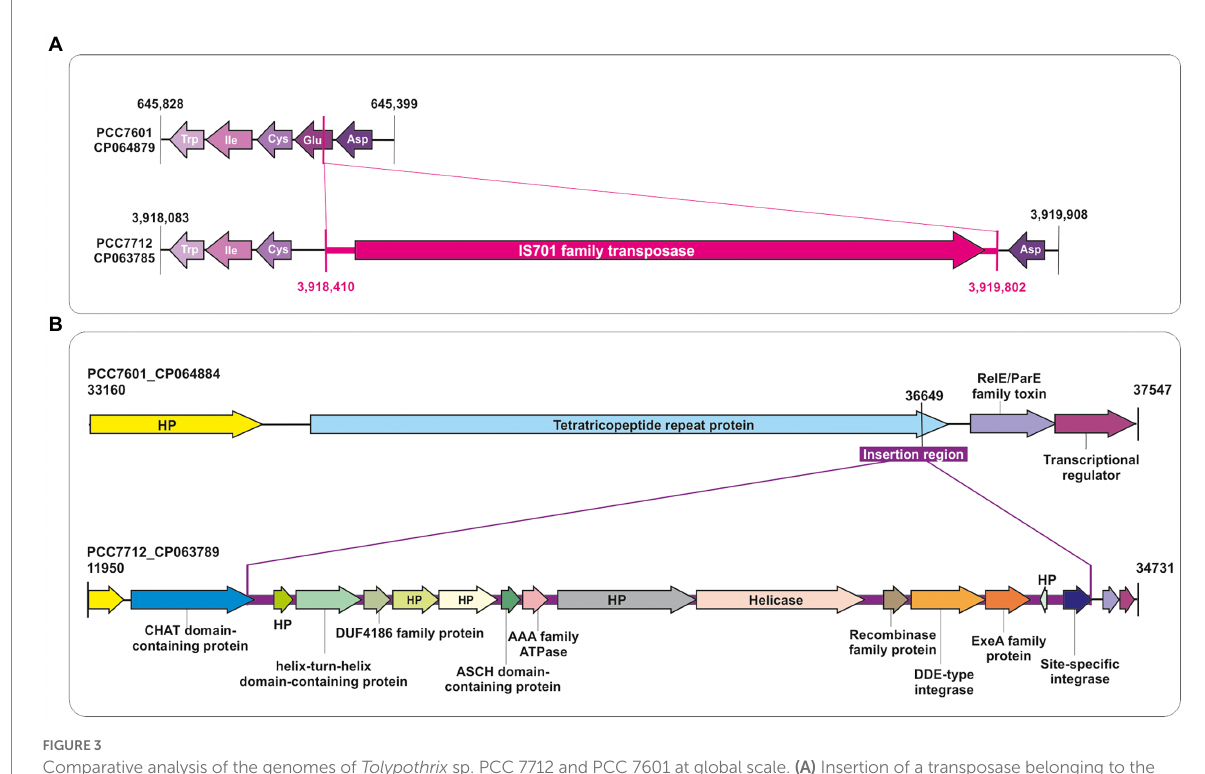
FIGURE 3 Comparative analysis of the genomes of Tolypothrix sp. PCC 7712 and PCC 7601 at global scale. (A) Insertion of a transposase belonging to the IS701 family located in the gene encoding the tRNA-Glu in the PCC 7712 chromosome. (B) Comparison of contigs PCC 7601_CP064884 and PCC 7712_CP063789, which differ by a large insertion sequence containing a number of protein-coding regions like five hypothetical proteins (HP), a helix-turn-helix domain-containing protein, an ASCH domain-containing protein, a DDE-type integrase, and an ExeA family